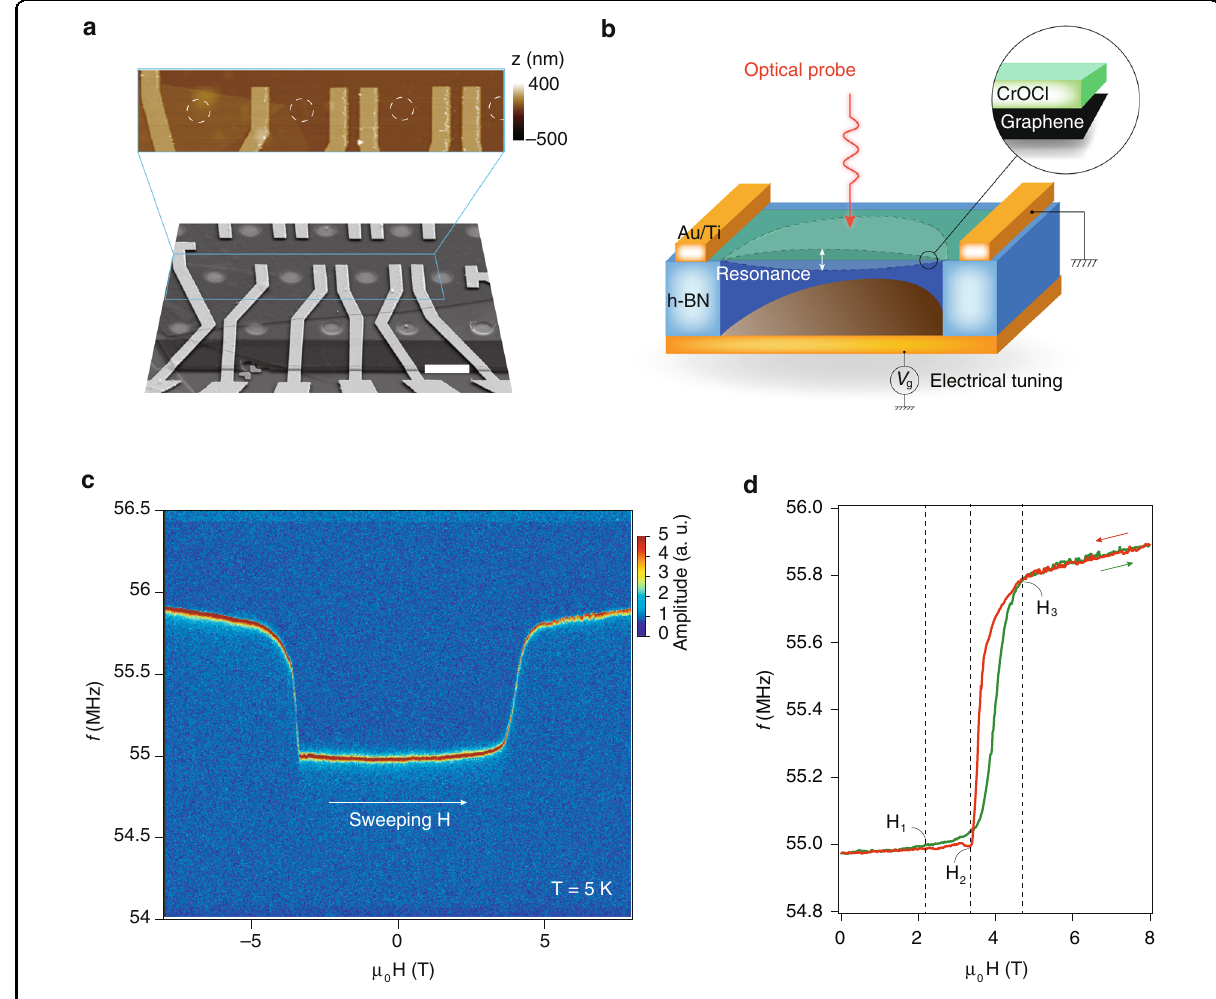
Fig. 5 Demonstration of a CrOCl/graphene vdW NOEMS using our technique. a Bird view of SEM image of the CrOCl/graphene NOEMS array using the method described in Fig. 1, with the boxed region scanned by AFM. It is seen that the drum-like cavities (dashed circles in the AFM image) are invisible under AFM. Scale bar = 5 μ m. b A cartoon illustration of the as-prepared of CrOCl/graphene NOEMS. c Color map showing the resonance frequency of the CrOCl/graphene NOEMS in the parameter space of frequency and magnetic fi elds at a temperature of 5 K. d Line pro fi le of the resonance frequency f 0 extracted from ( c ), as a function of magnetic fi eld. Data were obtained in trace and retrace, with a magnetic phase transition from H 1 to H 3 , with f 0 blueshifts of about 0.8